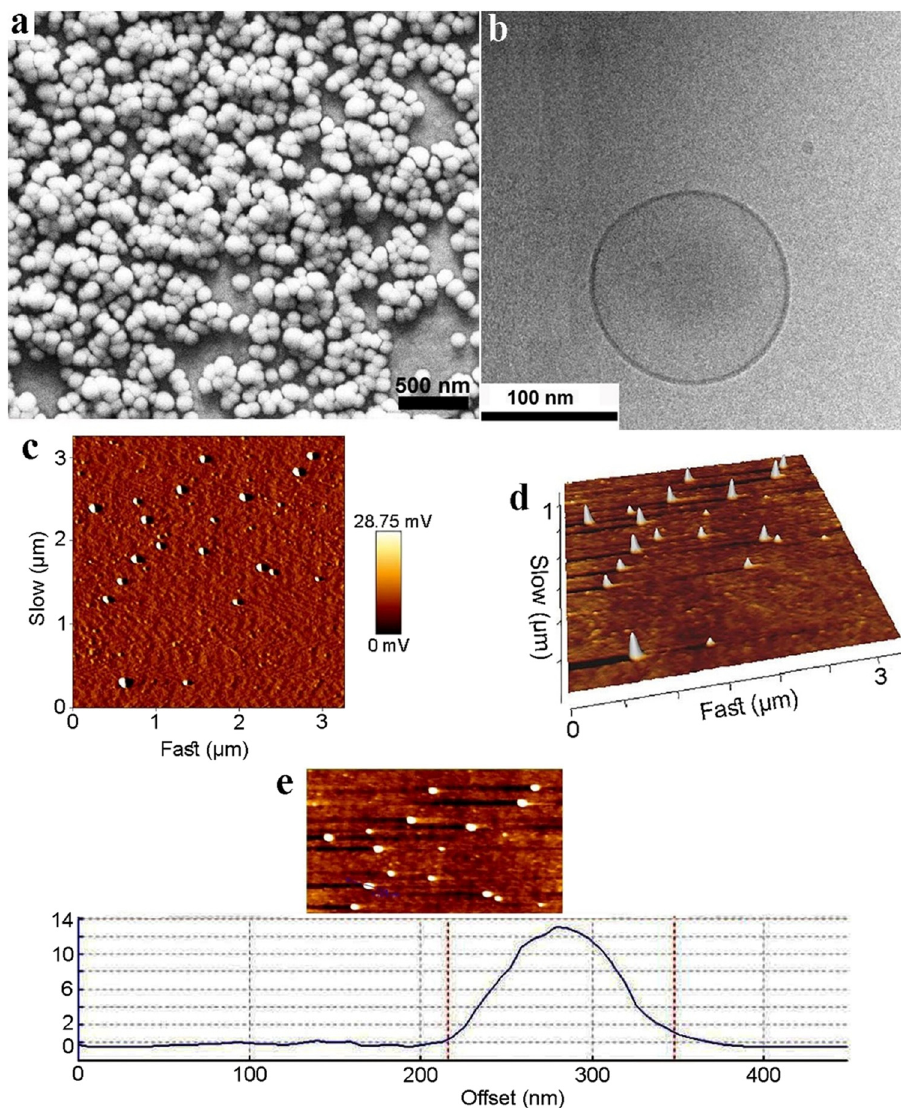
Figure 3: ( a ) SEM image of the modi fi ed niosomal NPs; ( b ) cryo - TEM image of the modi fi ed niosomal NPs; ( c – e ) 2D, 3D, and line analysis of the AFM image of the modi fi ed niosomal NPs,